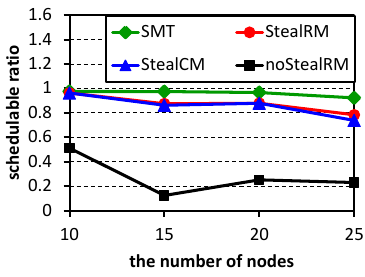
Figure 6. Schedulability comparison among all methods. SMT, satisfiability modulo theories; StealRM, slot-stealing scheduling algorithm based on rate-monotonic; StealCM, slot-stealing scheduling algorithm based on criticality monotonic.